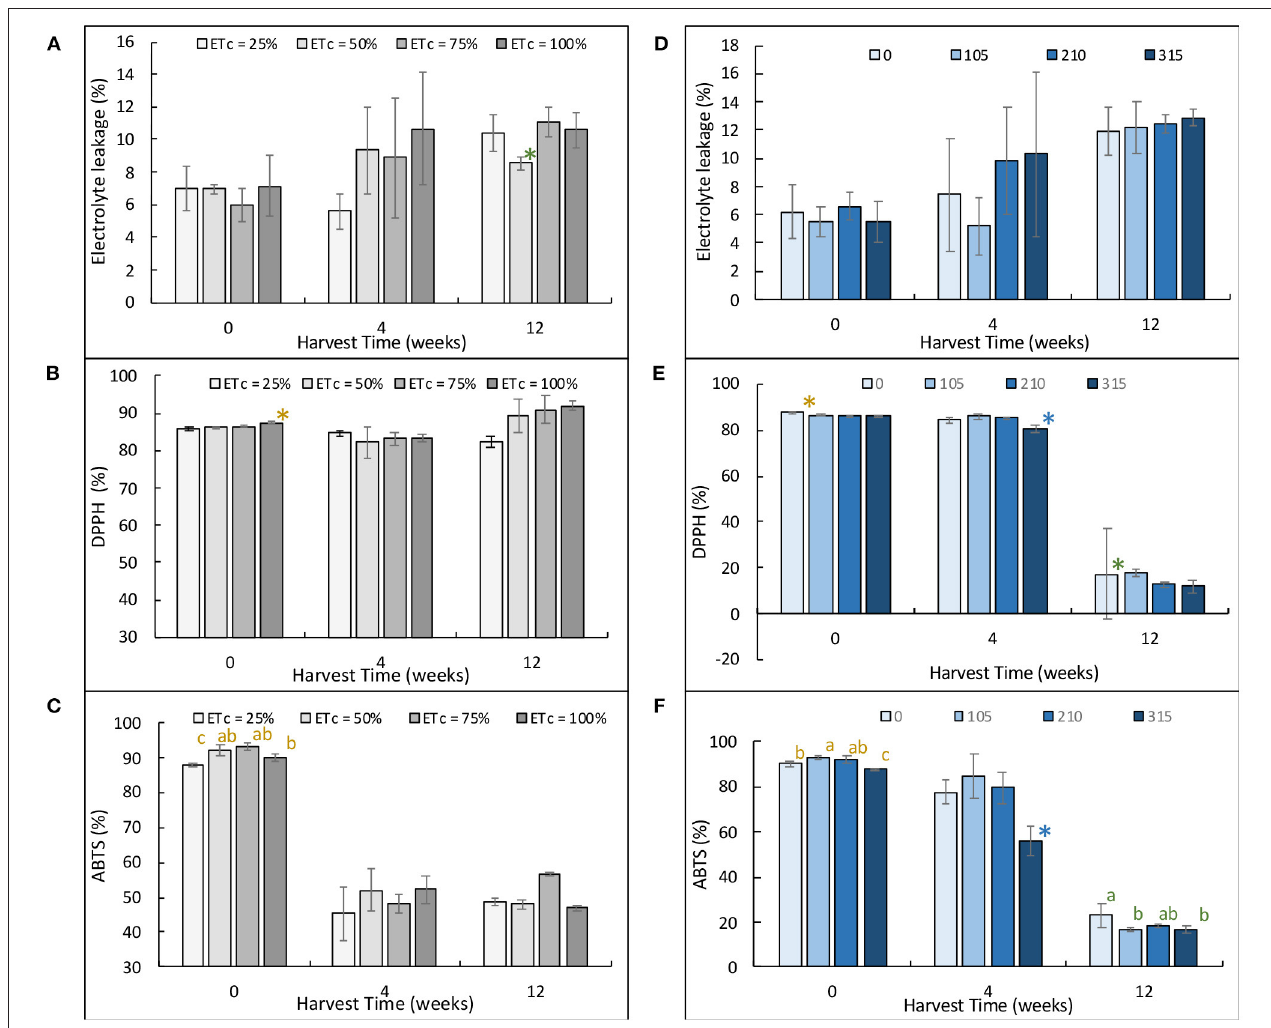
FIGURE 2 | Plant stress response as determined by electrolyte leakage (A,D) , DPPH antioxidant potential (B,E) , and ABTS antioxidant potential (C,F) of Japanese mints grown in the evaporative greenhouse system. The figures on the left are for Mentha arvensis grown in the evaporative greenhouse with different water regimes, and figures on the right are for Mentha arvensis grown in the evaporative greenhouse different level of nitrogen fertigation. *Represents significant difference at a 95 percent confidence.